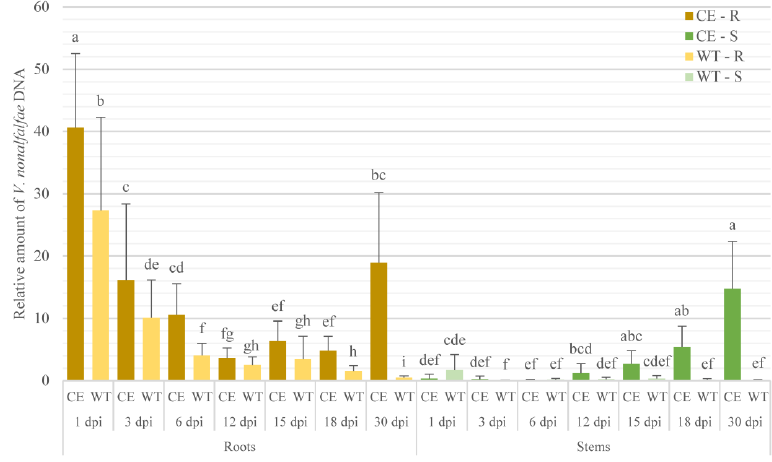
Figure 1. Colonization of V. nonalfalfae in roots (R) and stems (S) of susceptible (“Celeia”, CE) and resistant (“Wye Target”, WT) hop cultivars at different sampling times after inoculation (days postinoculation, dpi). Fungus quantity was determined with qPCR and normalized to hop reference gene DRH1. Data were analyzed by one-way ANOVA and Duncan’s post hoc test for root samples, and by the Kruskal–Wallis rank-sum test and the Holm–Bonferroni method for stem samples. Different letters denote statistically significant differences between root or stem samples at p ≤ 0.05. Data are presented as mean ± SD. Plants 2020 , 9 , 841